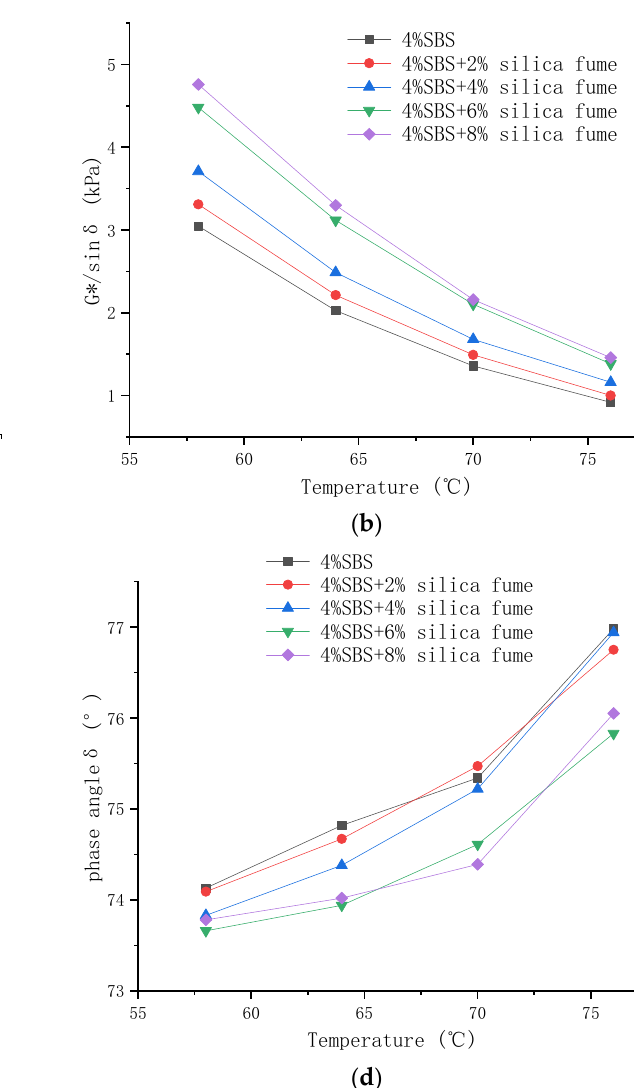
Figure 2. ( a ) Relationship between G*/sin δ and the temperature before aging and ( b ) after aging; ( c ) relationship between the phase angle ( δ ) and temperature before aging and ( d ) after aging.